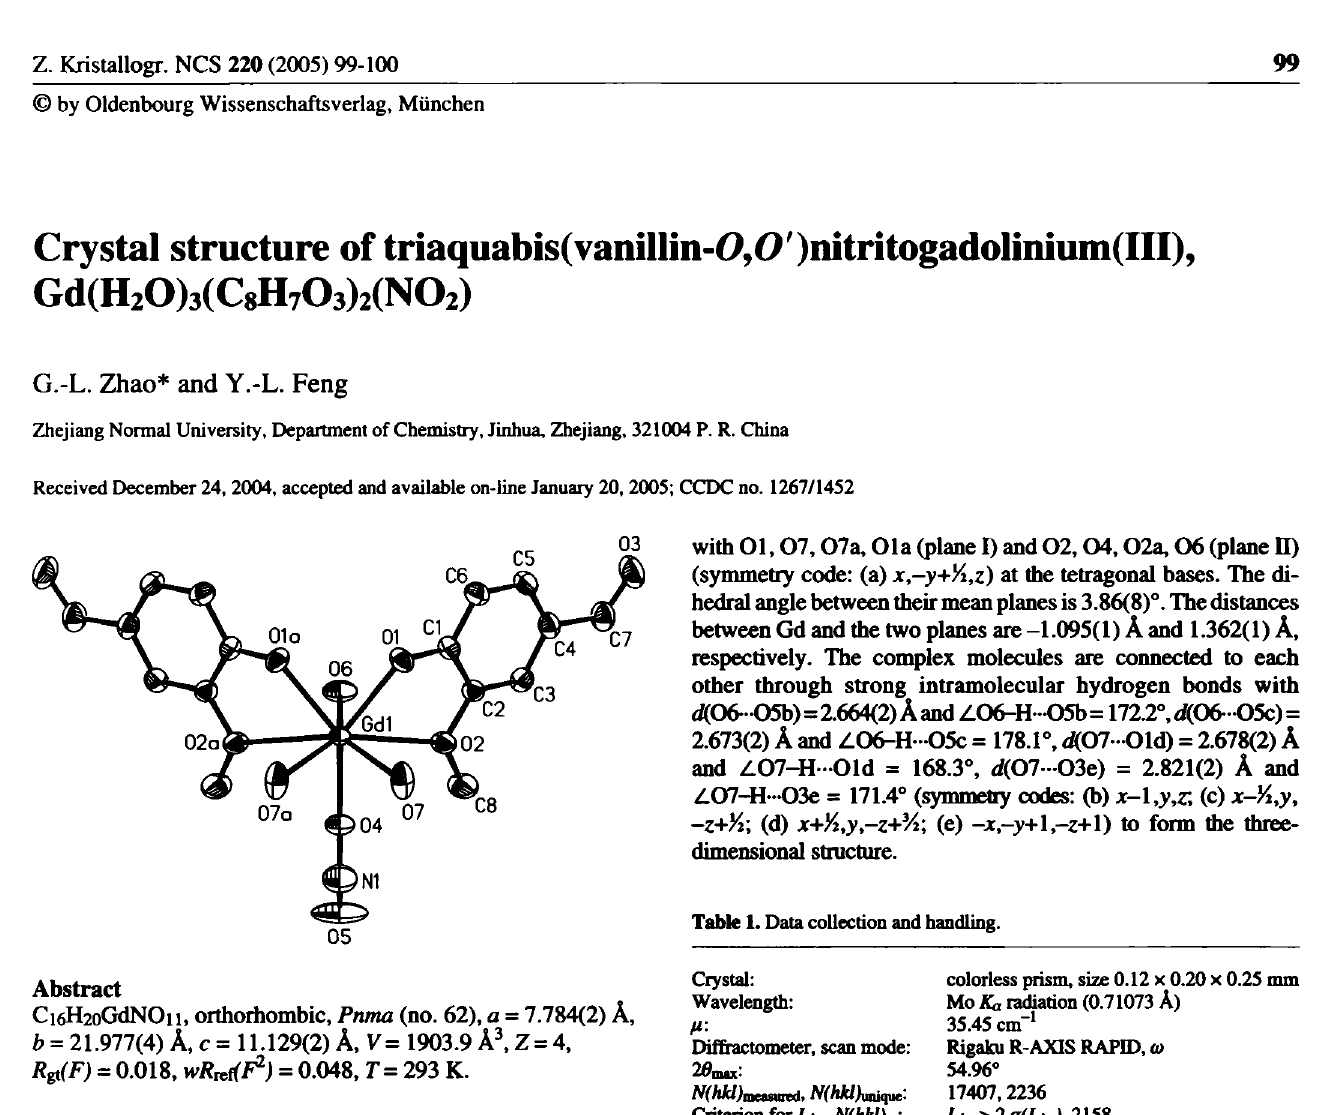
Table 2. Atomic coordinates and displacement parameters (in A 2